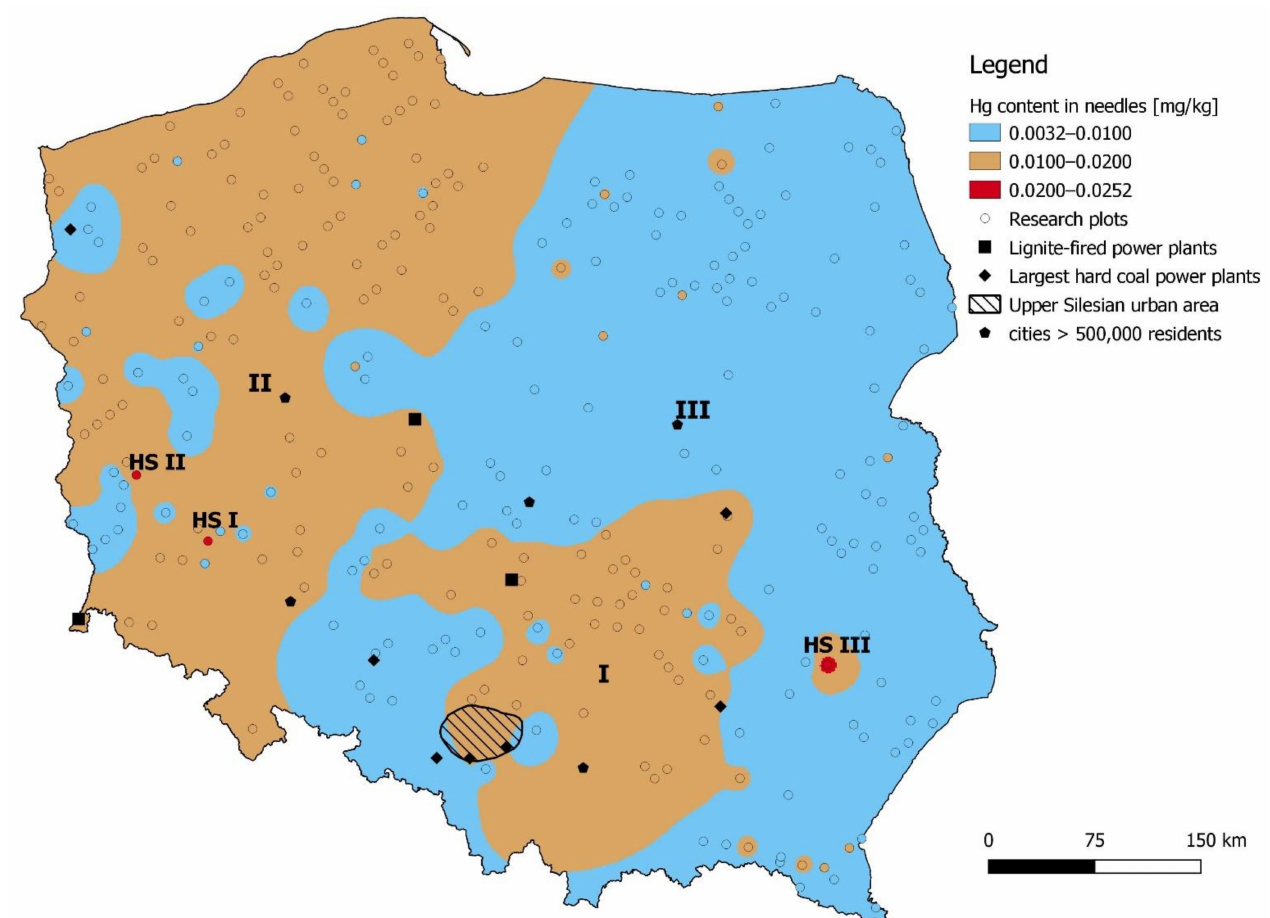
Figure 3. Spatial variation in Hg concentrations in pine foliage in Poland. Roman numerals indicate areas with different concentrations of Hg—I: central Poland; II: western Poland; III: remaining area with lower Hg concentrations up to 0.01 mg kg − 1 ; HS I: hot spot I near Zielona G ó ra; HS II: hot spot II in the copper-exploitation region; HS III: hot spot III near Jan ó w Lubelski.